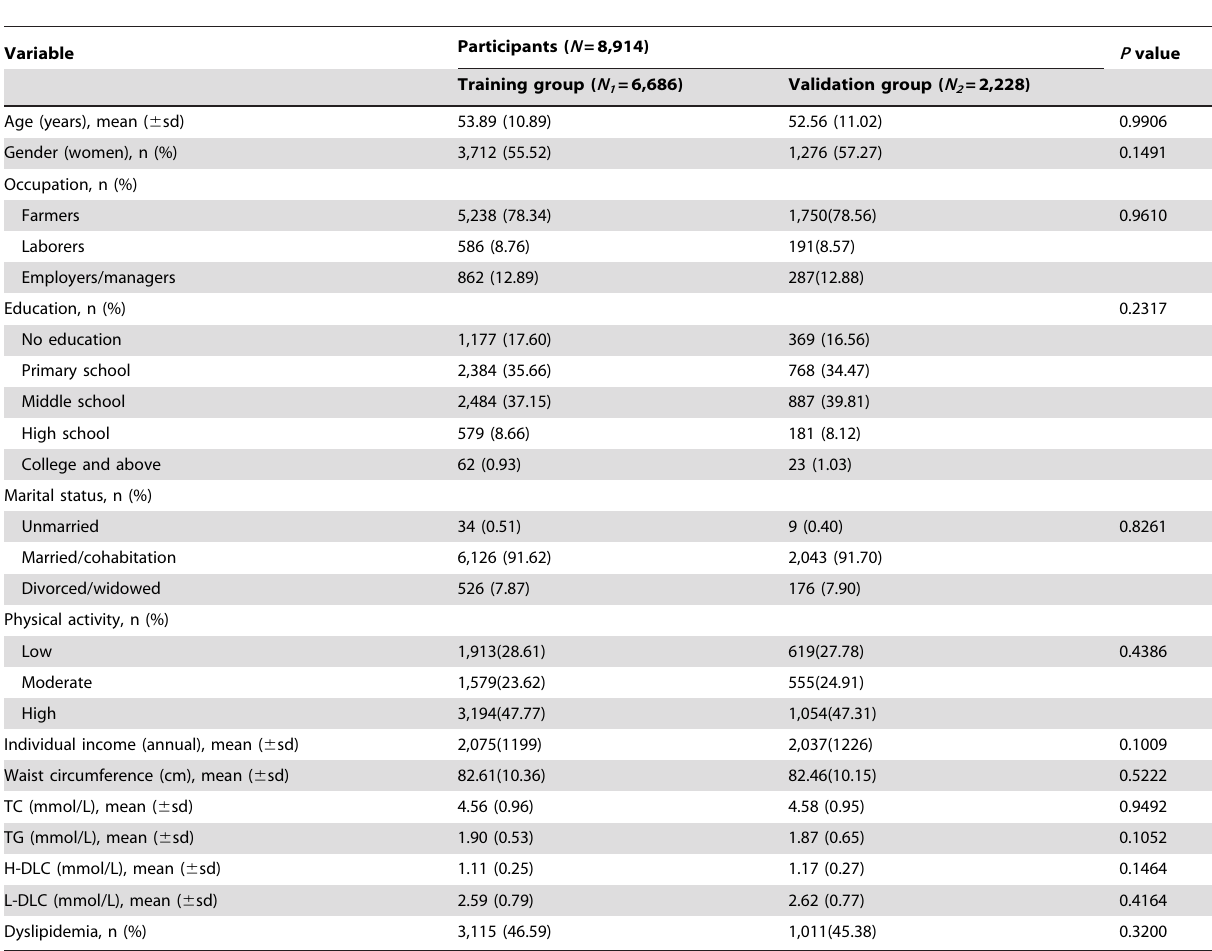
Table 1. Comparison of baseline characteristics between the training and validation